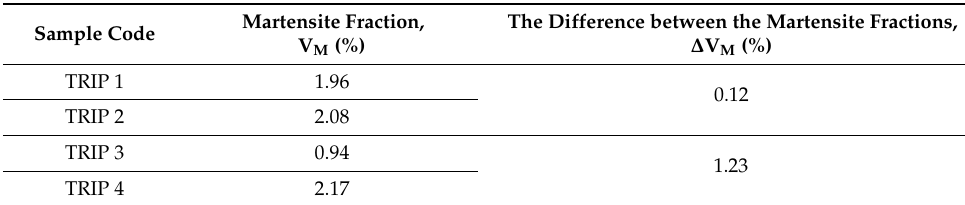
Table 6. Martensite fractions V M in the investigated samples and differences between them in steels with similar chemical